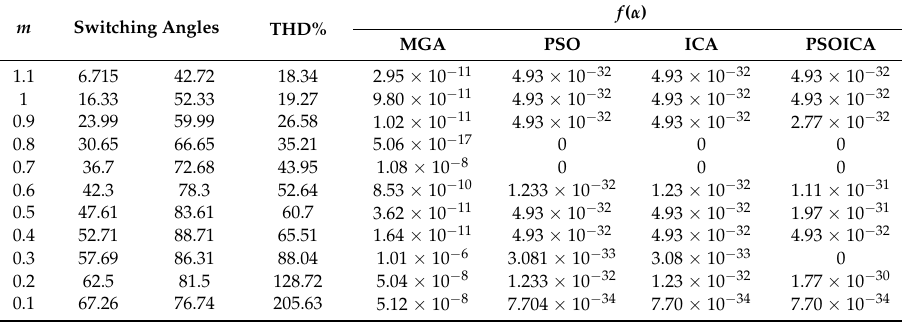
Table 3. Comparing the performance of the PSOICA to those of the multi-population genetic algorithm (MGA), PSO, and